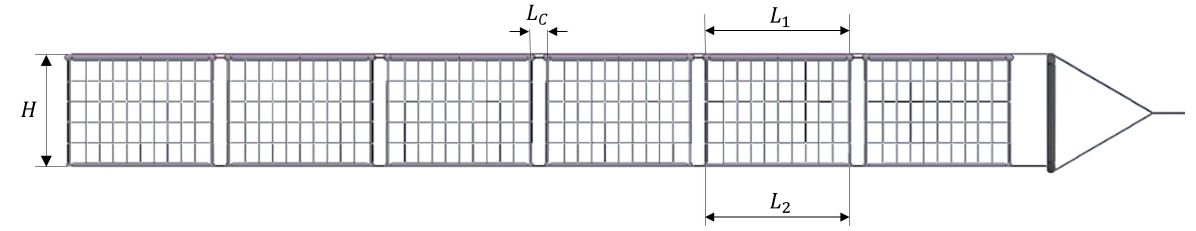
Figure 2. The aquaculture SPM system, side view.